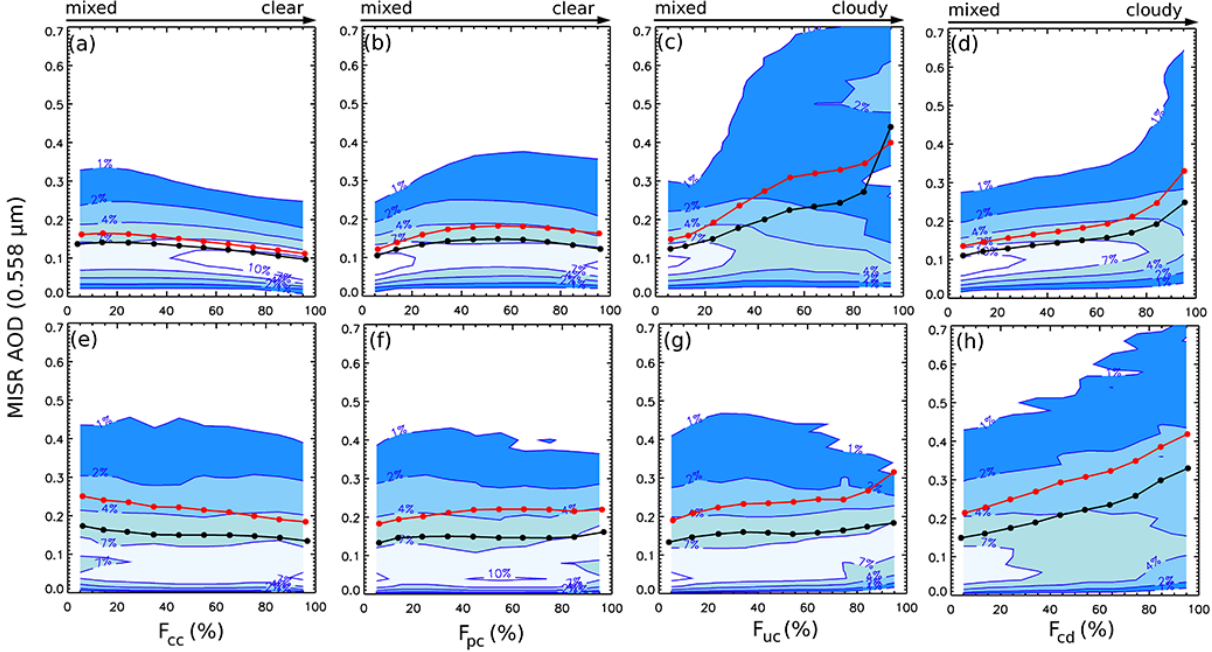
Figure 2. MISR AOD as functions of the percentage of occurrences of the cloud flags from the MODIS cloud mask products: (a, e) confident clear fraction ( F cc ) , (b, f) probably clear fraction ( F pc ) , (c, g) uncertainty clear fraction ( F uc ) and (d, h) cloudy fraction ( F cd ) . (a) to (d) are for the over-water data and (e) to (h) are for the over-land data. The color contour represents the fractional data density for every 10% cloud fraction. The red and black dots represent the mean and median MISR AOD values within a 10% cloud fraction bin,